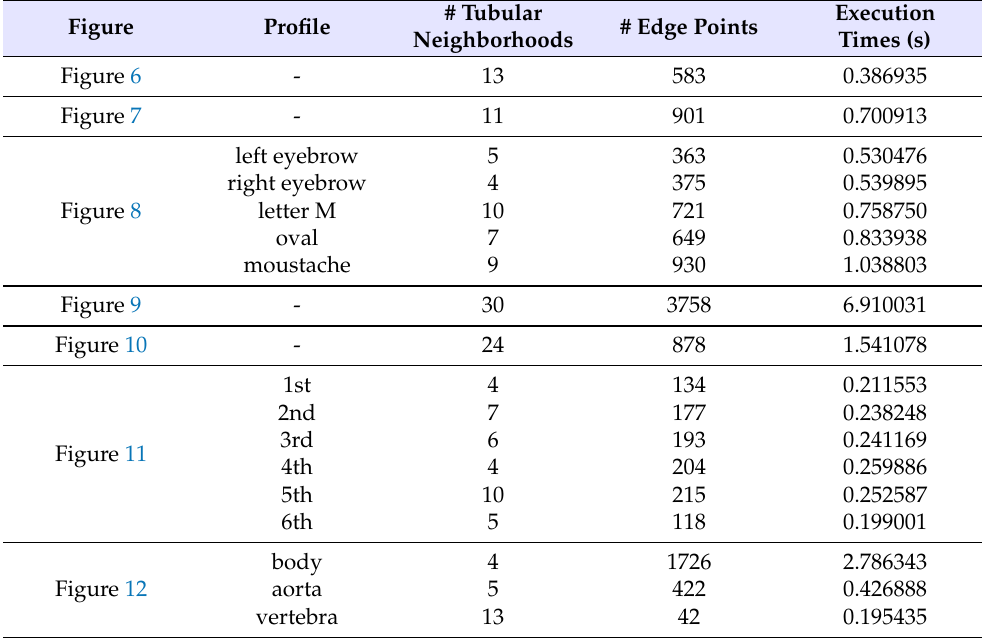
Table 4. Number of tubular neighbohoods, number of edge points and execution times (in seconds) for the profiles presented in Figures